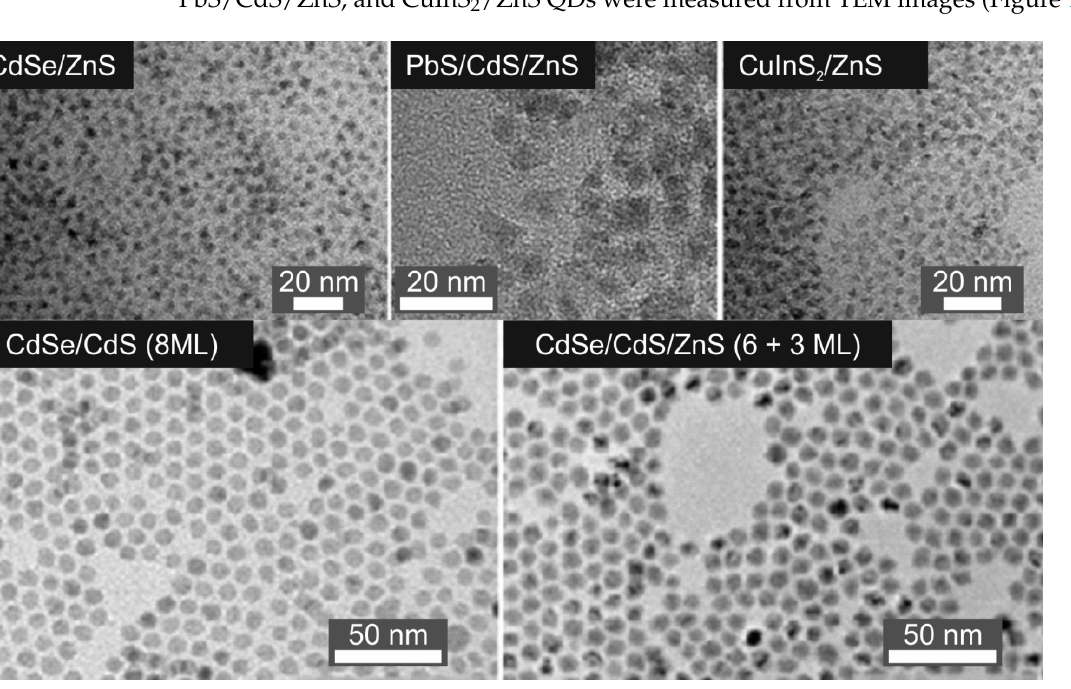
Figure 1. Analysis of the structure of the synthesized quantum dots by means of transmission electron